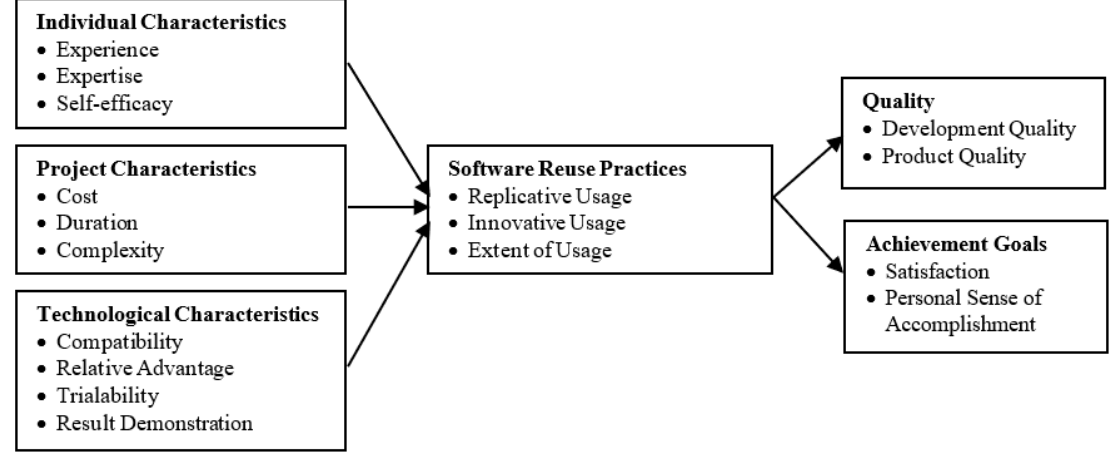
Figure 1. The proposed framework.